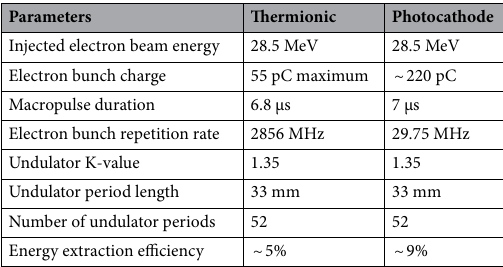
Table 1. Electron beam and undulator parameters.